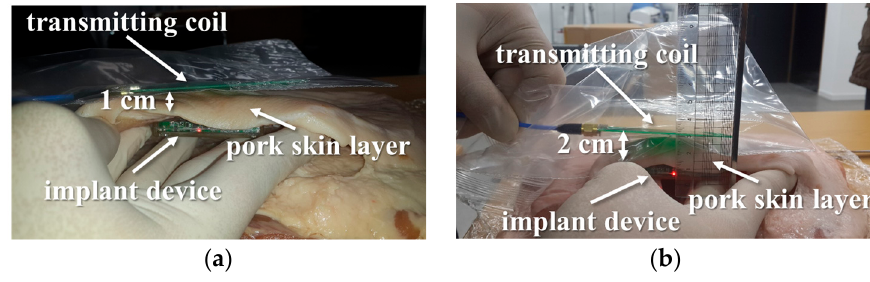
Figure 16. Wireless charging test in pork at distances of ( a ) 1 and ( b ) 2 cm.